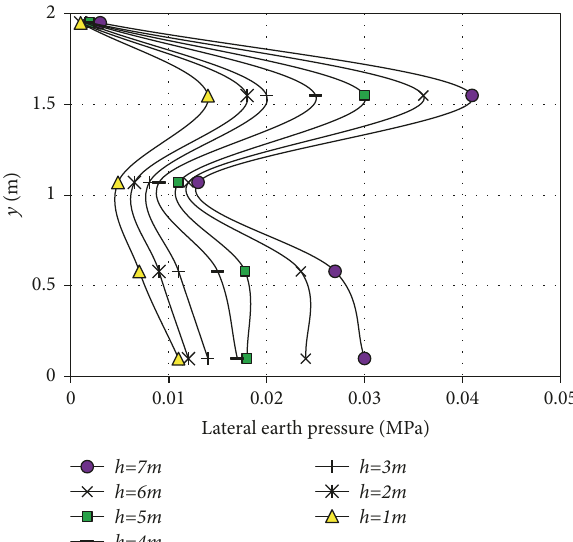
Figure 7: Distribution of lateral pressure on the left wall of section II.